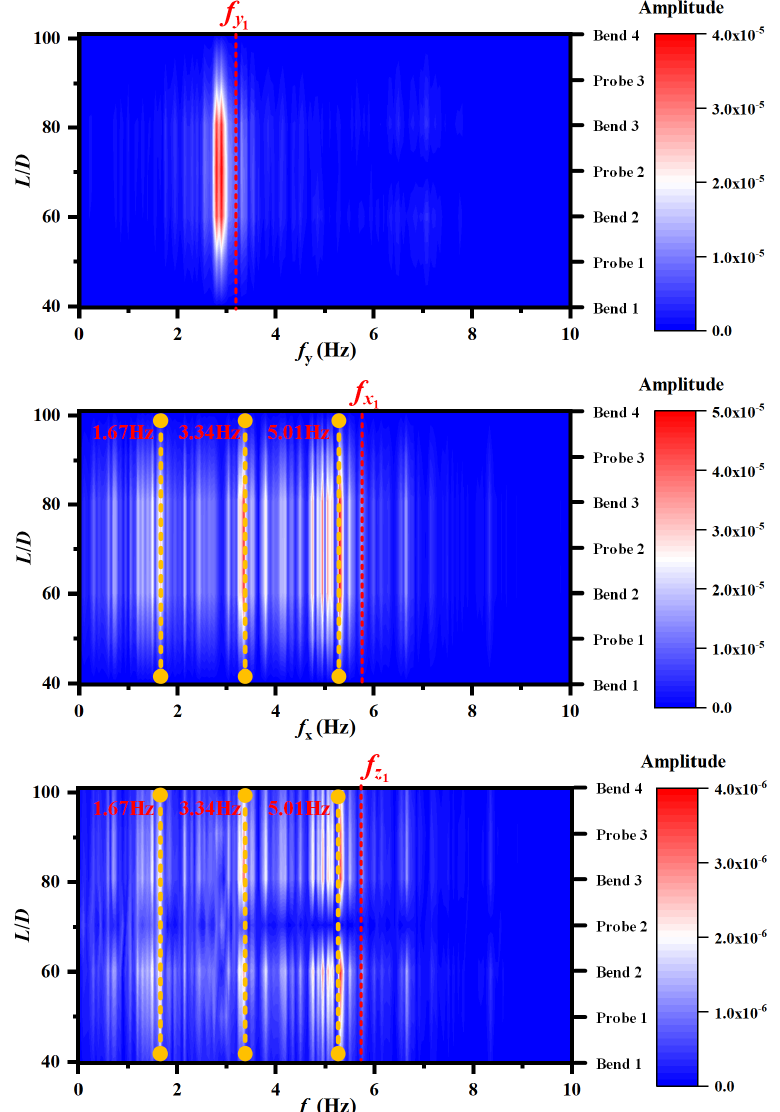
= 6 kg/s and Q L = 144 kg/s. m-in m-in